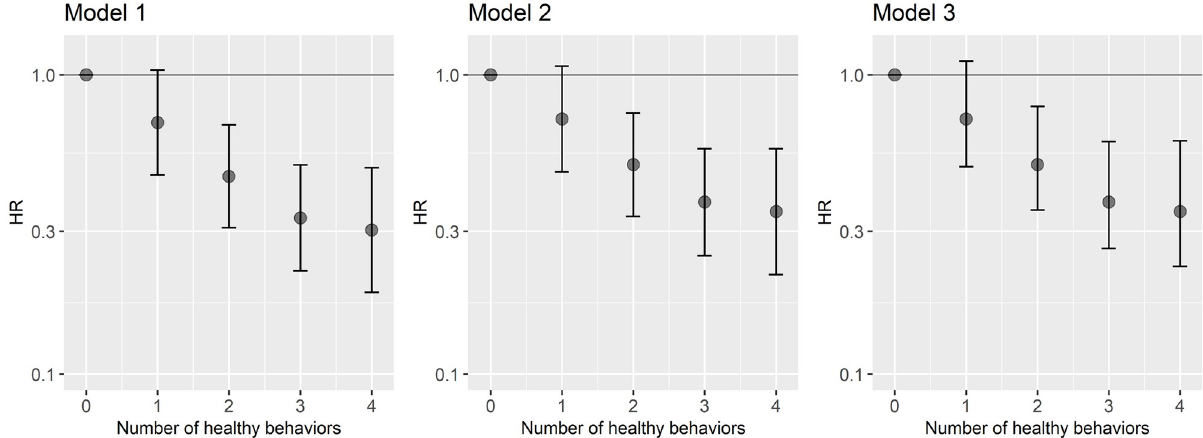
Fig 2. Association between the number of healthy behaviors at age 50 and the onset of frailty over a mean follow-up of 20 years. Model 1: age as a timescale, adjusted for sex, ethnicity, marital status, and wave at inclusion. Model 2: model 1 additionally adjusted for education and occupational position. Model 3: model 2 additionally adjusted for the number of morbidities at age 50. Associated estimations are in S4 Table. HR, hazard ratio.